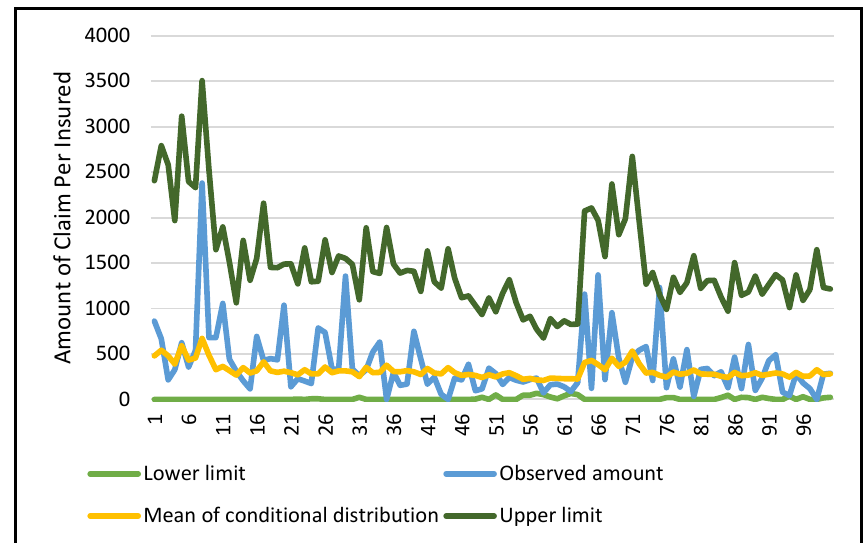
Fig. 4. Lower and upper limits of the first 100 prediction intervals for the amount of claim per insured given in Pan et al. [10] ( 𝛼 = 0.05